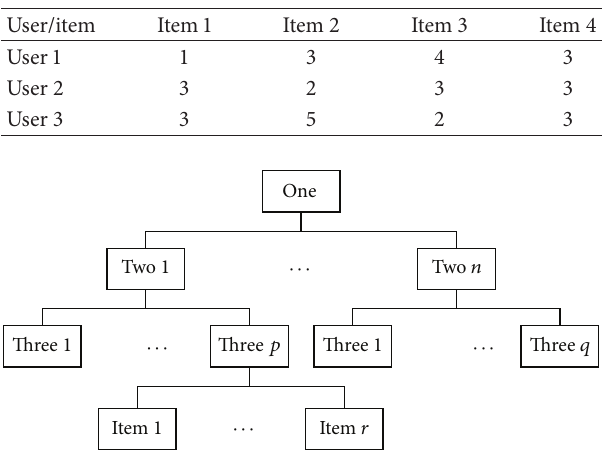
Table 2: User-item rating matrix.